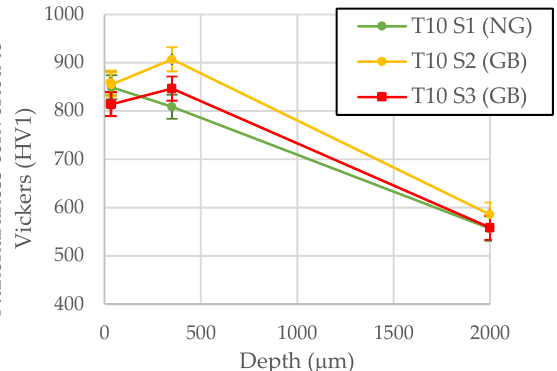
Figure 5. SEM micrographs of T3 S2 sample taken at ( a ) valley area and ( b ) thread area of the shaft. Nanohardness measurements were taken, and the results represented in Figure 6 in order to analyse the effect of the different samples in T10 on MBN reveal more detail. It is important to note that, due to the well-known indentation size effect [21], hardness in- creases as the maximum penetration decreases. Thus, HV is expected to be higher in the case of nanohardness measurements than in that of microhardness measurements. How- ever, both nanohardness measurements in T10 S2 and T10 S3 (AG) samples show a slight superficial drop (from 350 to 3 µm) in hardness.